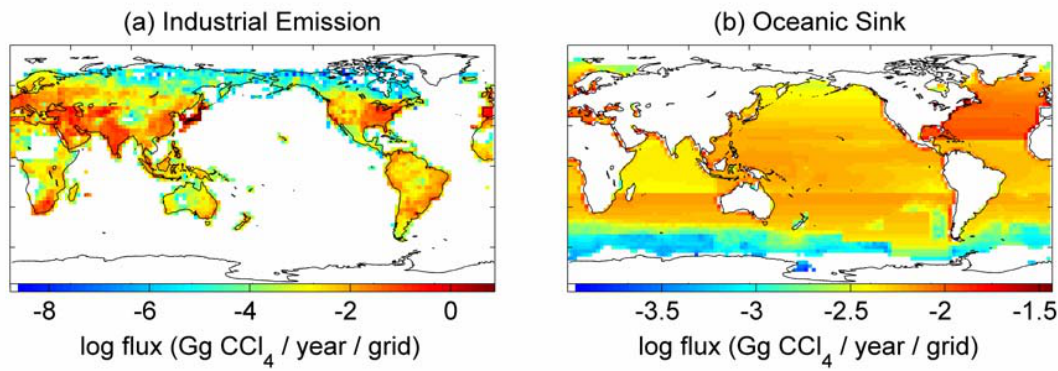
Fig. 6. Inversion results for the 12-month average regional industrial emissions of CCl 4 . Blue asterisks and lines show the reference (a priori) magnitudes and their error bars, with the magnitudes assumed to be linearly decreasing. Red circles and lines show the optimized (a posteriori) estimates and their error bars. Black squares and lines show the 2-year running mean optimized estimates and their errors (see text). The total industry emissions are the sum of the eight regional emissions.